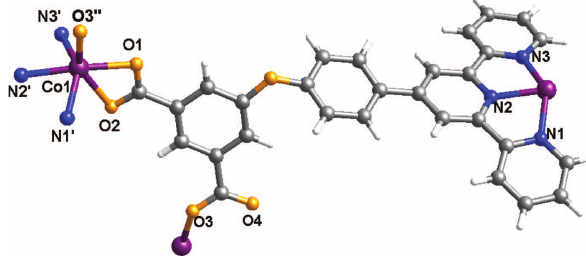
Table 1: Data collection and handling.